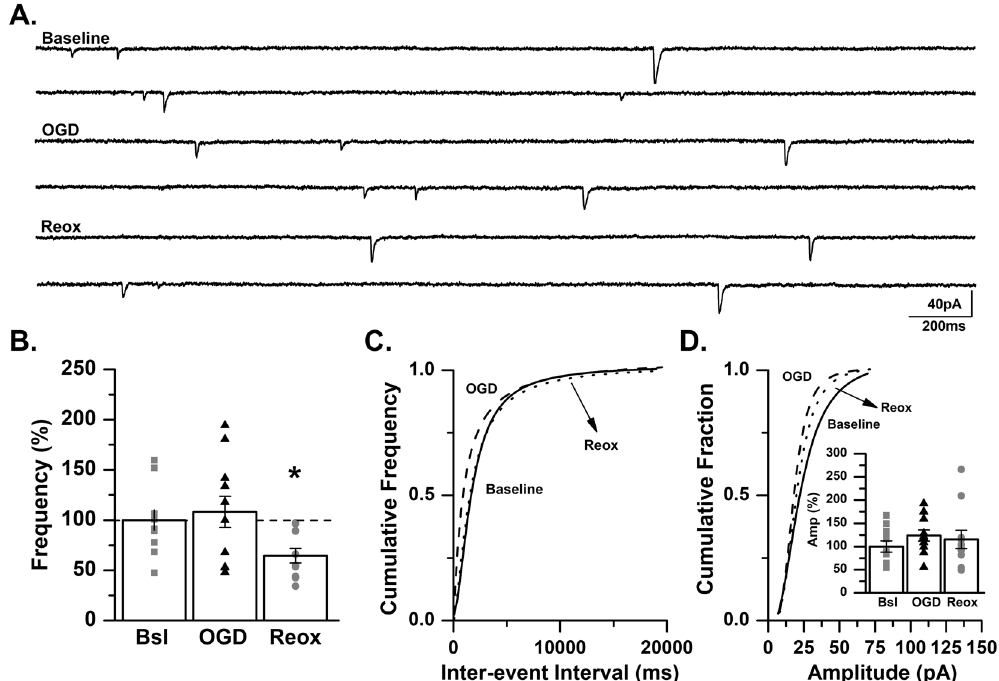
Figure 8. Increase in mEPSC frequency during OGD is absent in a GluK2 − / − mouse. ( A ) Representative traces from a GluK2 − / − mouse recorded at baseline, during OGD and during reoxygenation (reox) demonstrating that mEPSC frequency is not changed during OGD. ( B ) Averaged data demonstrating that mEPSC frequency is not altered during OGD but is significantly reduced during reox as a percent of baseline ( n = 11 cells, 9 animals; baseline, Bsl: 0.53 ± 0.05 Hz; OGD: 0.58 ± 0.1 Hz; reox: 0.34 ± 0.05 Hz). * p < 0.05, K-W ANOVA. Data presented as percent mean ± SEM. ( C ) Representative inter-event cumulative frequency histogram demonstrating no change in the mEPSC frequency in a GluK2 − / − mouse. ( D ) Representative amplitude cumulative histogram demonstrating no change in mEPSC amplitude during OGD. Inset showing averaged data for mEPSC amplitude at baseline, during OGD and during reox, (baseline, Bsl: 15 ± 1.82 pA; OGD: 17.41 ± 1.8 pA; reox: 15.71 ± 2.2 pA). Data presented as percent mean ± SEM. Baseline, solid line; OGD, dashed line; reox, dotted